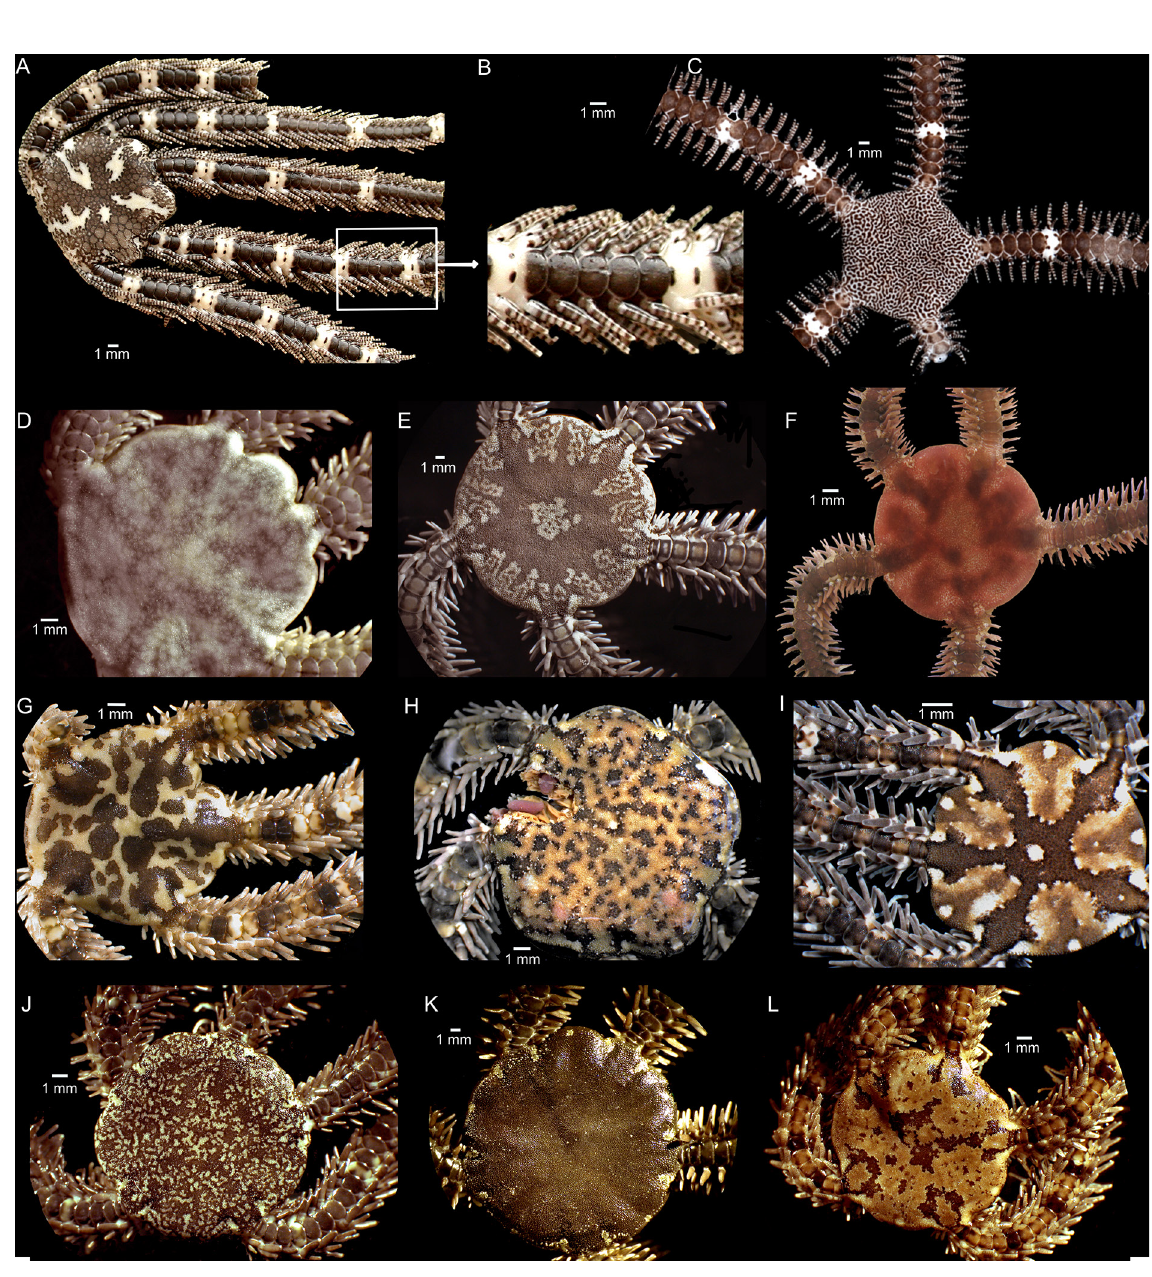
Fig. 2. Colour variations in species of Ophiocoma ( Breviturma ) subgen. nov. A-C . Ophiocoma doederleini Rowe & Pawson, 1977 . A . Reticulated specimen (UF5318). B . Close-up of annulated arm spines. C . Densely reticulated specimen (UF6518). D . Ophiocoma brevipes Peters, 1851 (SMNH- 133230). E-F . Ophiocoma dentata Müller & Troschel, 1842 . E . Variegated specimen (SMNH-133232). F . Uniformly reddish brown specimen (URUN2009-11047). G-L . Ophiocoma krohi sp. nov. paratypes. G . With large patches (SMNH-Type-8533). H . Small irregular spots (MNHN-IE-4302). I . Star-shaped radiating pattern (SMNH-Type-8531). J . Densely mottled (MNHN-IE-4301). K . Uniformly dark brown (SMNH-Type-8536). L . Light brown, sparsely mottled (UF13938). For institution codes see main